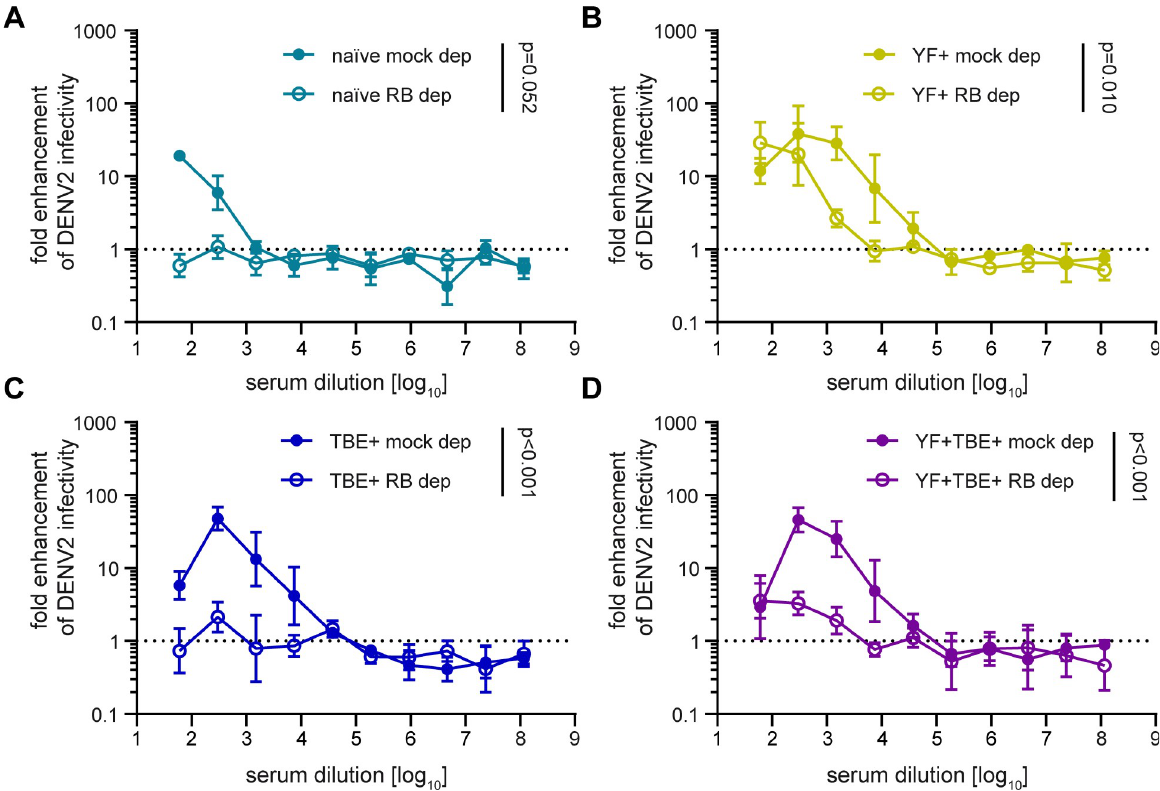
Fig 9. Effect of depletion of cross-reactive antibodies from serum pools with Rio Bravo E on ADE of dengue virus infection. Fc γ receptor- positive K562 cells were infected with dengue virus in the presence of serially diluted (A) flavivirus-na ï ve pool, (B) YF pre-vaccinated pool, (C) TBE pre-vaccinated pool, and (D) YF and TBE pre-vaccinated pool. IgG-containing serum pools were further depleted with RB E protein as described in Methods. Colored symbols: mock depletion, empty symbols: RB depletion. Data are shown as mean values +/- SEM from three independent experiments. Dotted line indicates no enhancement of infection. Comparison of fold-enhancement of dengue virus infection in the presence of depleted and mock-depleted pools was performed by applying a general linear model as described in Methods. p-values are indicated in the graphs. DENV2, dengue virus serotype 2; mock dep, IgM and mock-depleted serum pool; RB dep, IgM and Rio Bravo virus E-depleted serum pool.